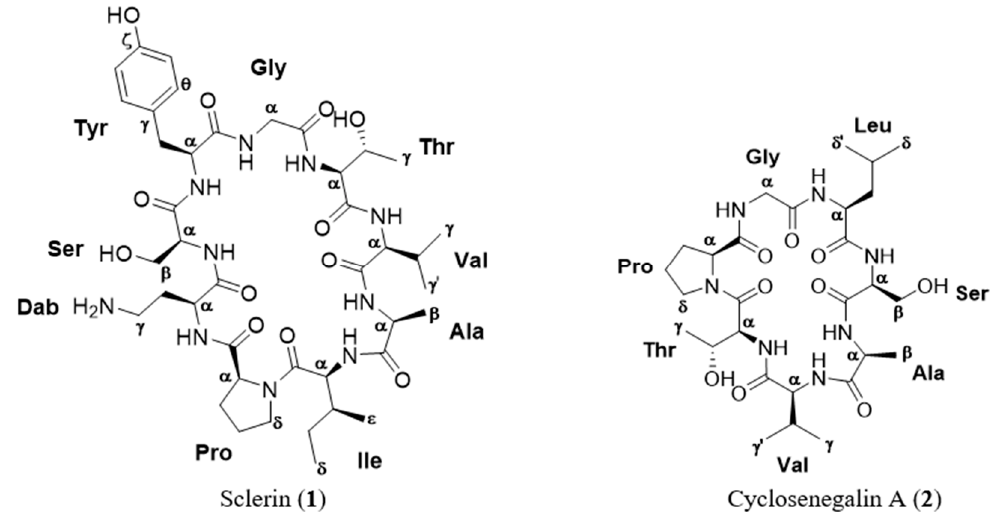
Figure 1. Structure of the cyclopeptides isolated from the methanol extract of Annona scleroderma .